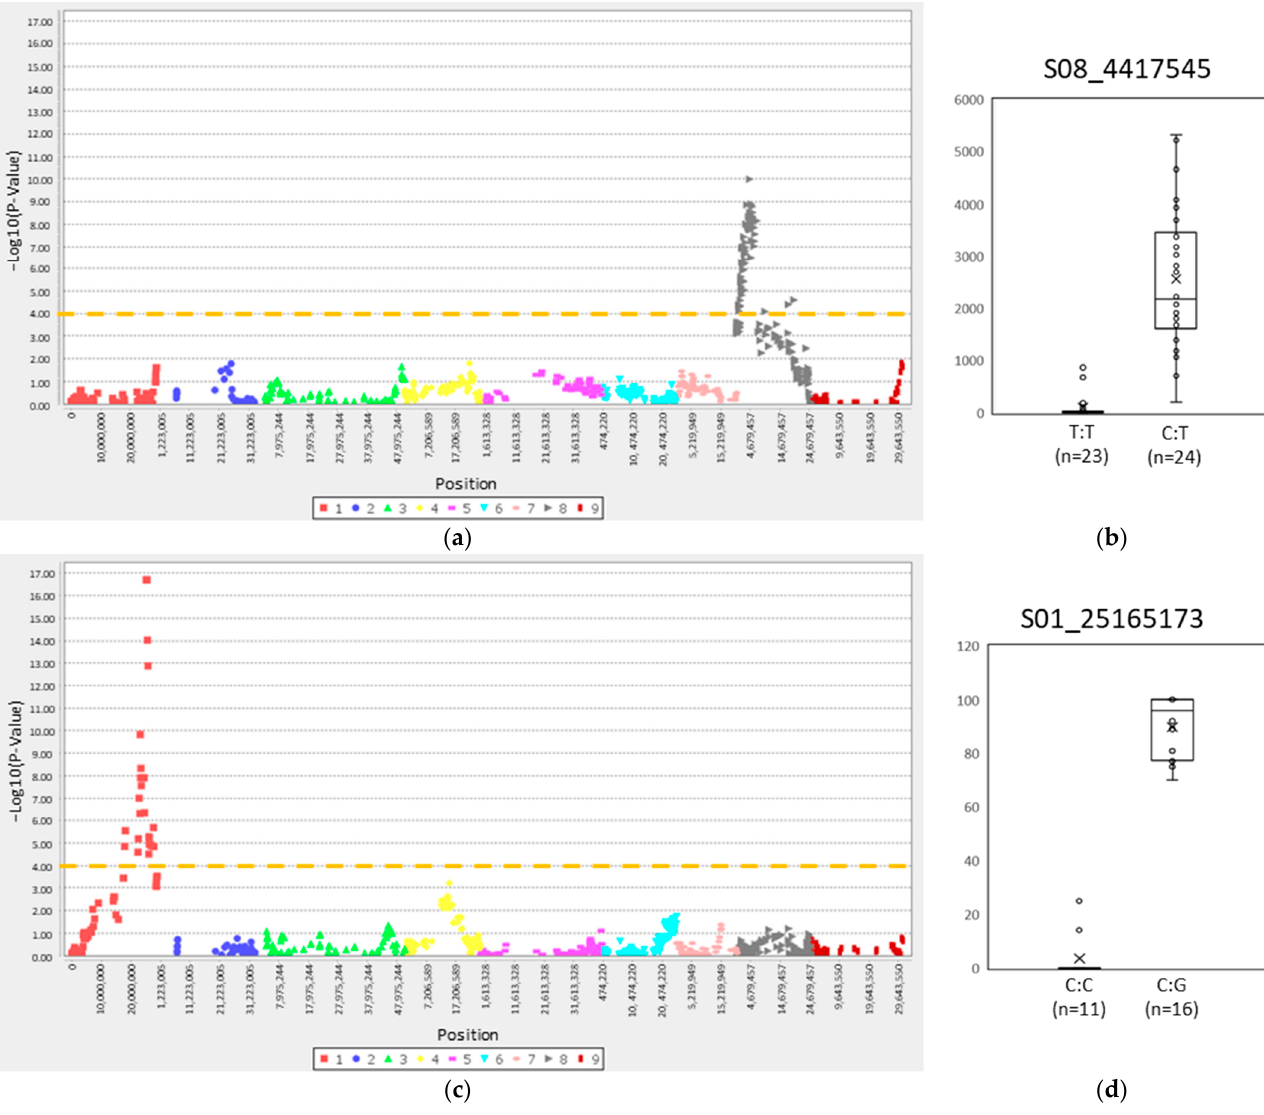
Figure 3. Association study for ‘Murco tt ’ gametes. ( a , b ) Number of pollen grains per anther; ( a ) Manha tt an plot. ( b ) Box plot representation for the most signi fi cant marker, SNP S08_4417545. ( c , d ) Polyembryony. ( c ) Manha tt an plot. ( d ) Box plot representation for the most signi fi cant marker, SNP S01_25165173. The orange line is the threshold for signi fi cant p -values.